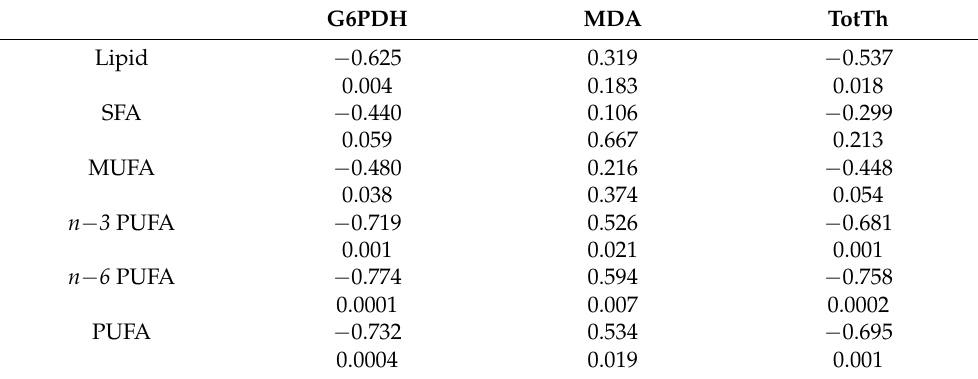
Correlation coefficients and the p -value below are given; the total lipid contents were derived from Vuori- nen et al. [49]; the number of salmon was